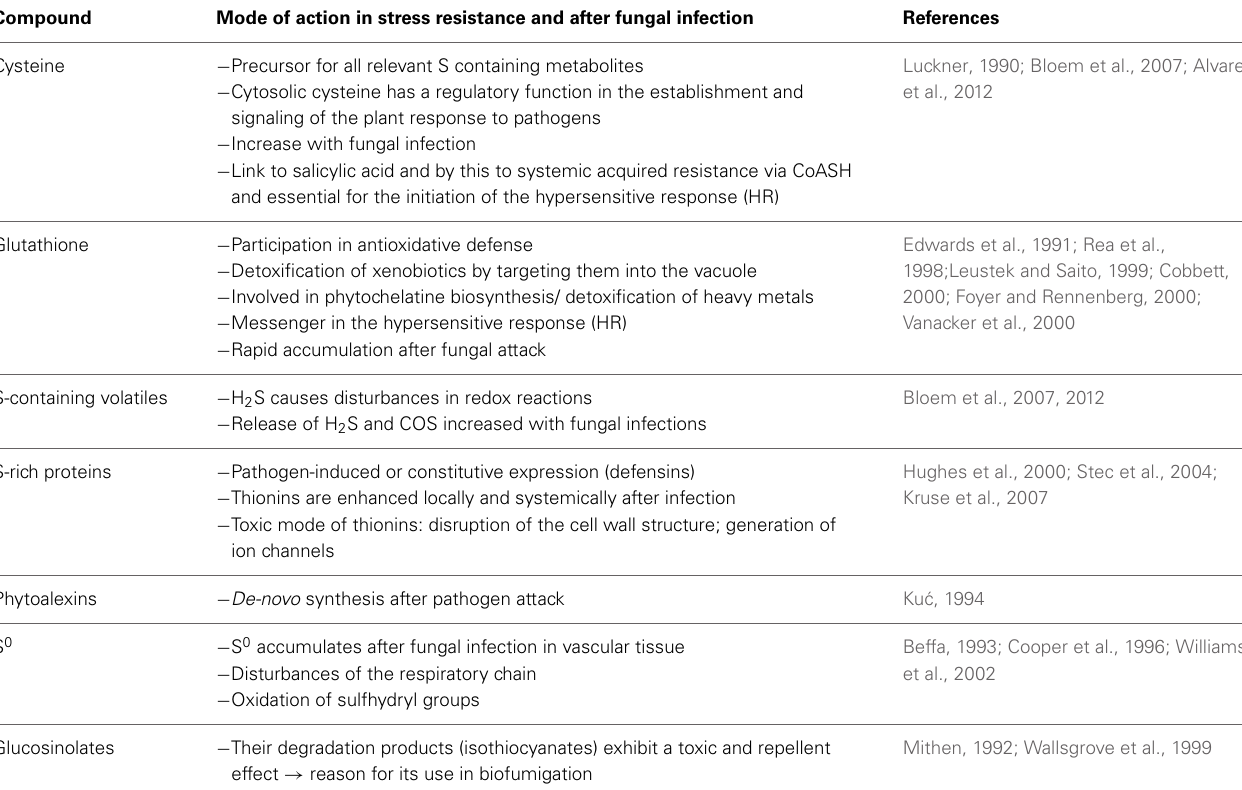
Table 2 | Possible mode of action of S-containing plant compounds in stress resistance and in response to fungal infection.